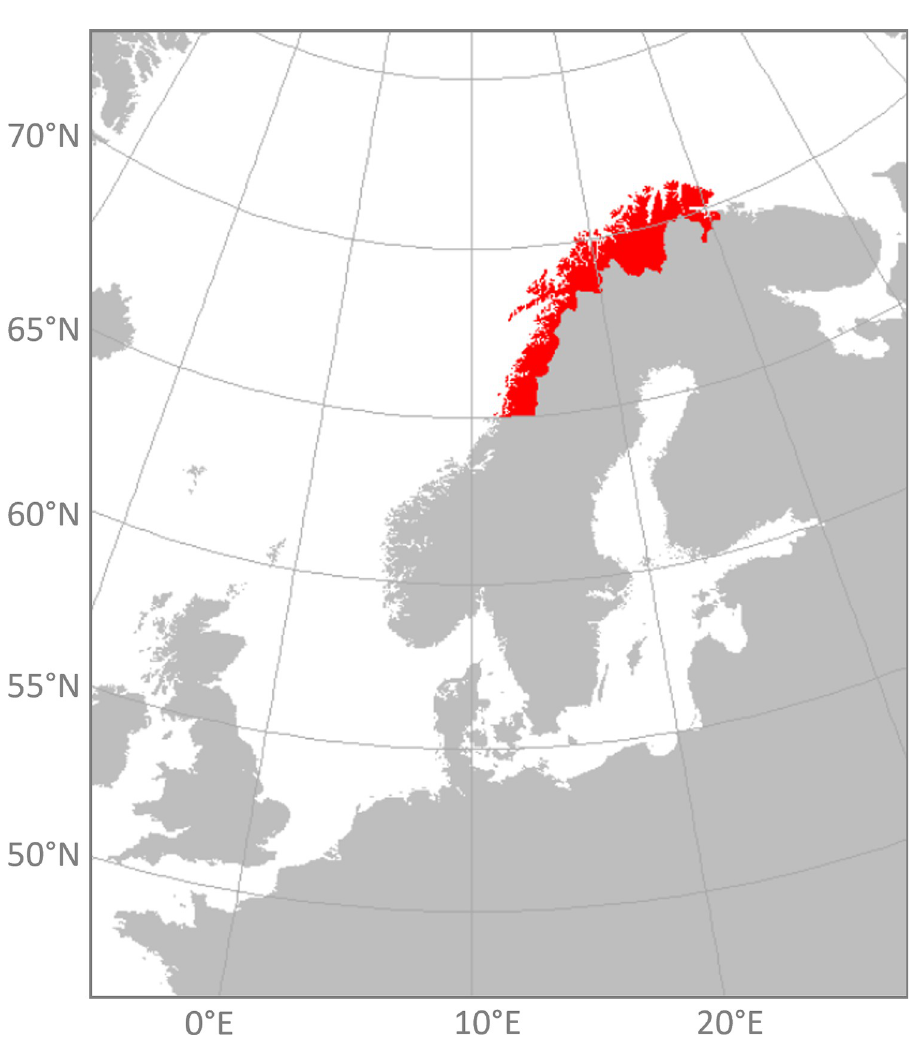
Fig 1. Map of the study area (marked in